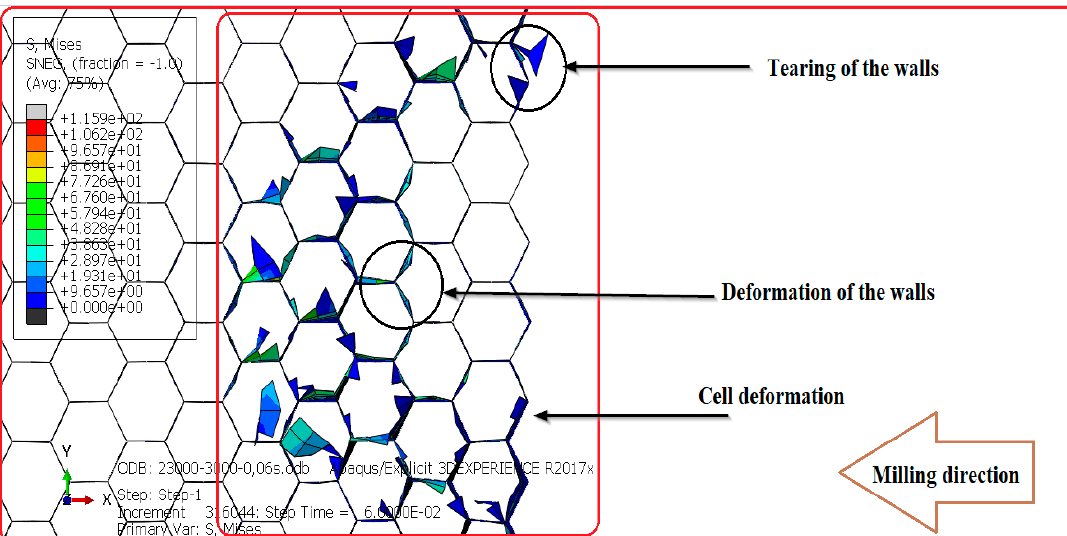
Figure 19. Resulting machined surface quality by the cutting blade of 19.3 mm. In the present study, the developed numerical model discloses three machining flaws throughout the milling of the Nomex honeycomb structure. The most common machining defects are tearing of the walls, deformation of the walls and deformation of the cells. Nevertheless, the numerical model does not show the burrs caused by the accumulation of material. This is due to the fact that the thin walls which form the structure were mod- eled by shell elements. Considering the obtained results, it was determined that the qual- ity of the machined surface is associated with the differences between the two components of the cutting tool, so that the quality of the machined surface deteriorates with increase in the diameter of the cutting blade. The large diameter of the cutting tool bends the thin walls of the Nomex honeycomb structure until they tear. In the end, to better meet the requirements of the industrial sectors concerned in terms of machined surface quality, it is necessary to take into consideration the gap between the two elements of the cutting tool.